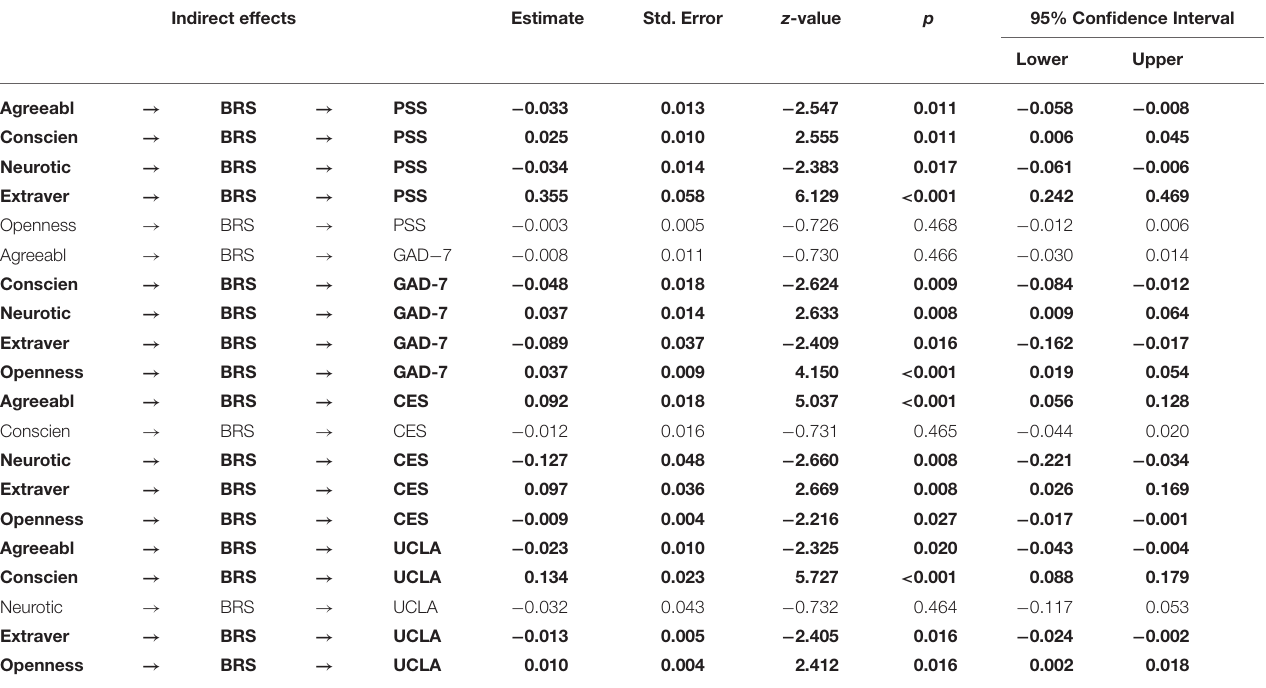
TABLE 6 | Structural equation modeling with resilience as mediator. Indirect effects Estimate Std.